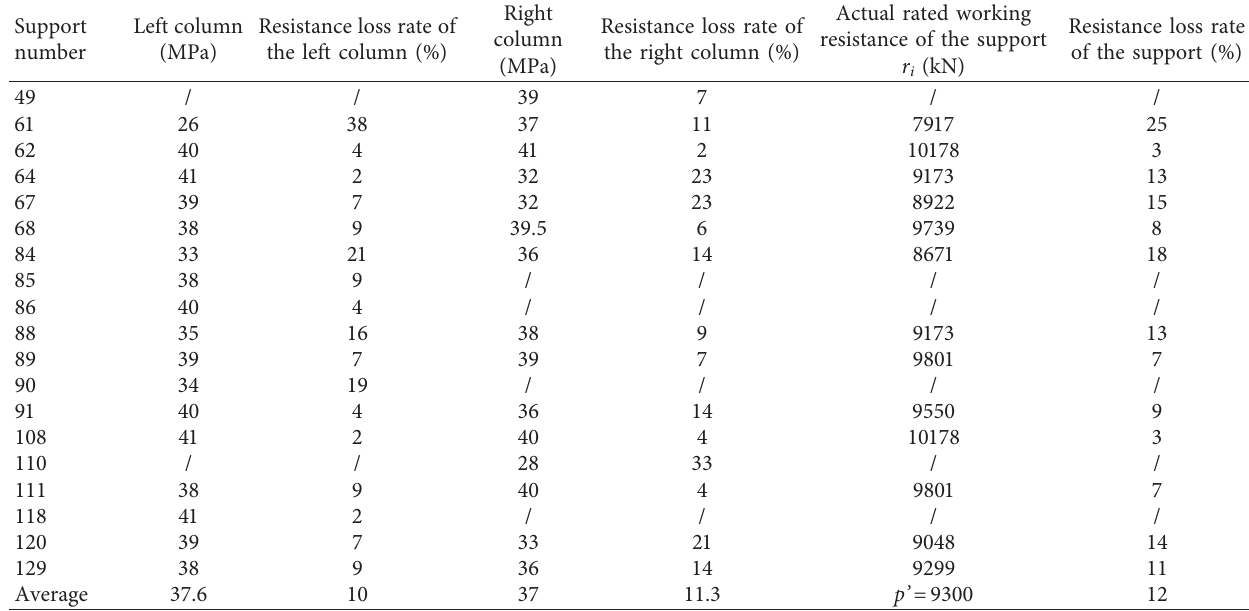
Table 1: Actual rated working resistance of the support.